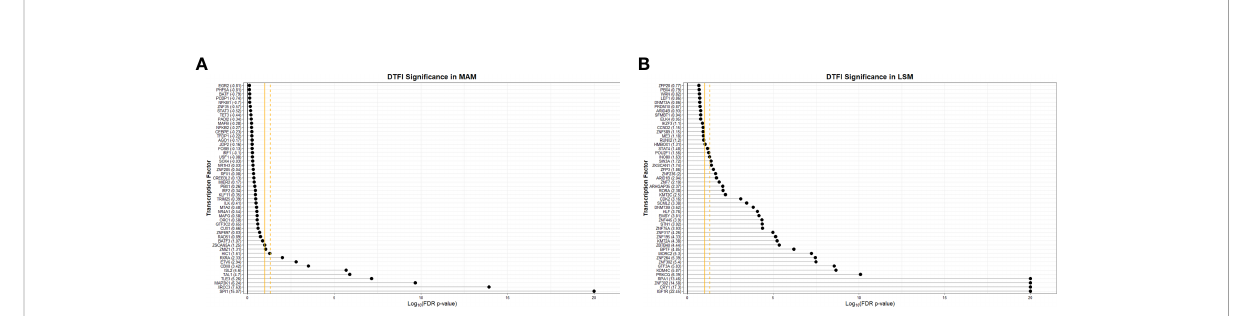
FIGURE 4 Signi fi cance of transcription factors based on differential transcription factor analysis. Dot plots demonstrate the signi fi cance of the top 50 transcription factors involved in the “ transition ” from health to sarcoidosis based on scaled differential transcription factor involvement (DTFI) within the MAM (A) and LSM (B) modules. DTFI was considered signi fi cant with a false discovery rate (FDR) p-value <0.1 utilizing the “ z-score ” method per the Monster algorithm. Gold solid vertical grid line represents a FDR p-value=0.1 and gold dashed vertical grid line represents FDR p-value=0.05. Numbers enclosed within parentheses next to transcription factor names on the y-axis represent scaled DTFI values standardized against the null distribution. Larger DTFI values indicate a greater magnitude of change in transcription factor gene targeting between